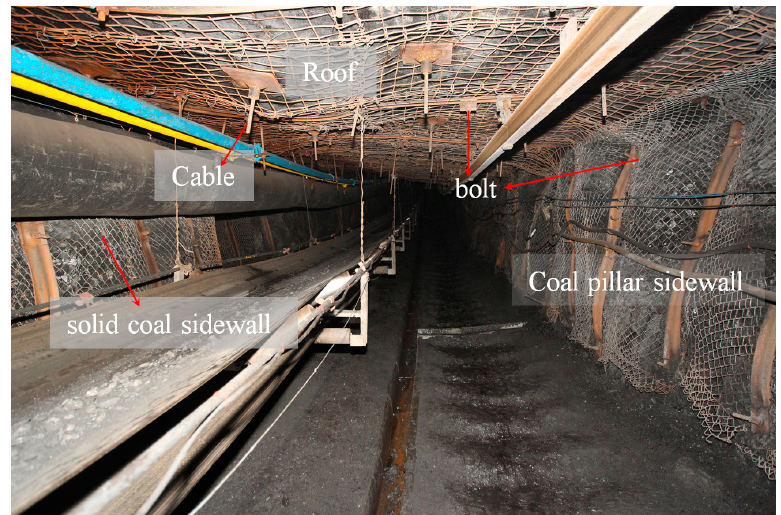
Figure 16. Photos of zone C in MTR 1513.